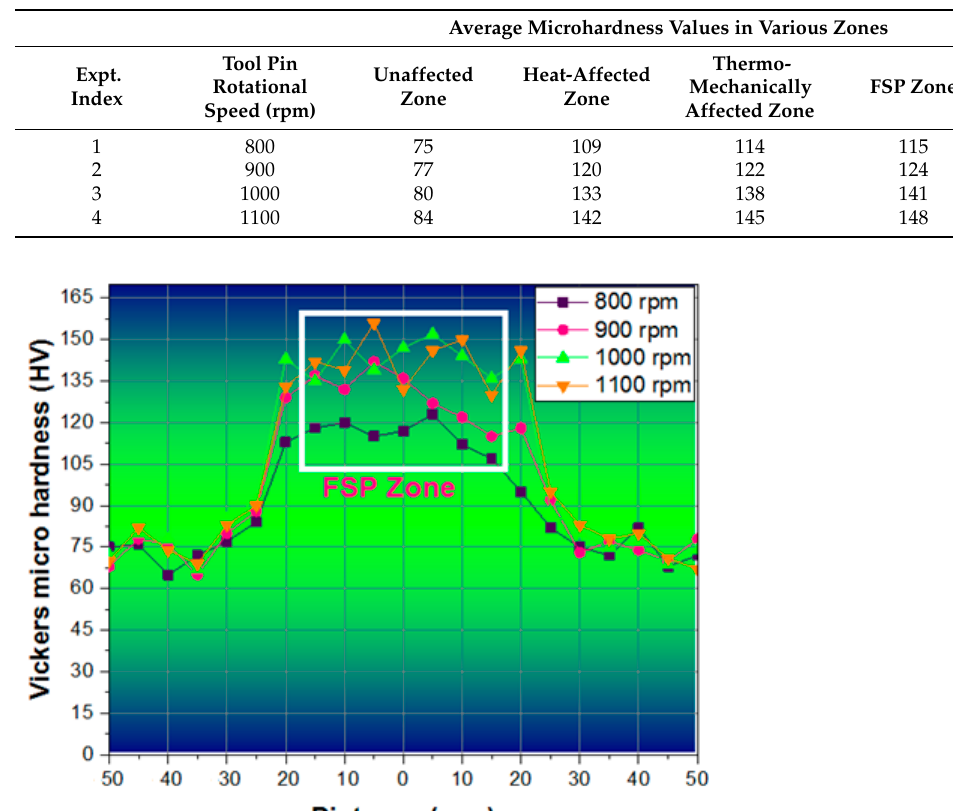
Table 4. Microhardness for the various zones of the FSP using different tool speeds.